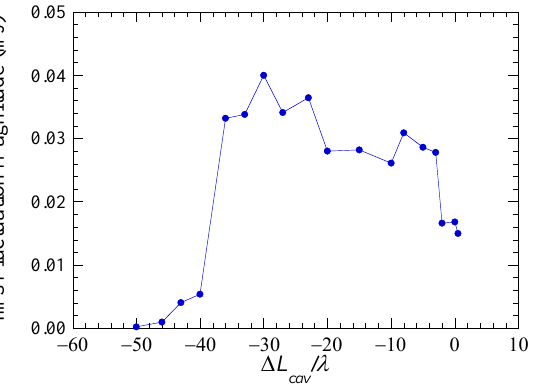
Figure 15. Standard deviation of the optical pulse energy as a function of cavity detuning ∆ L cav / λ for a undulator field strength of B u = 6.658 kG ( K rms = 1.055), while the other parameters are given in Table